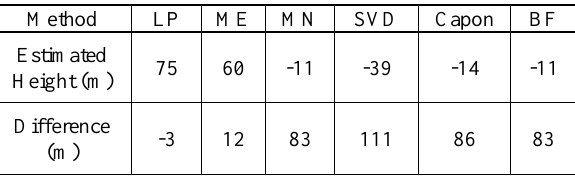
Table 1 . Estimated building heights and their